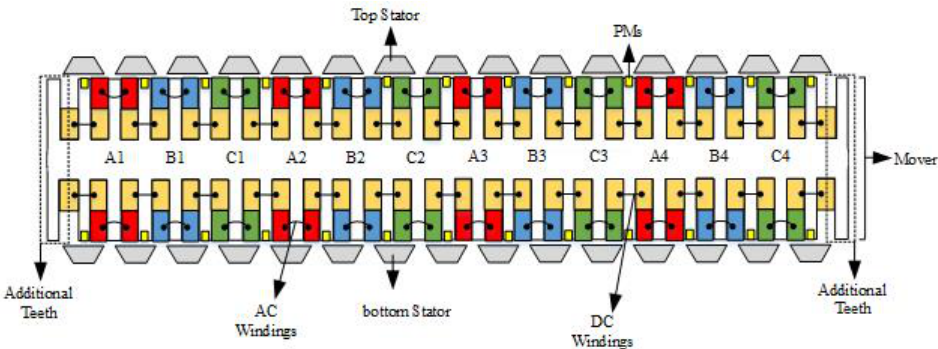
Figure 3. The 2-D schematic diagram of proposed